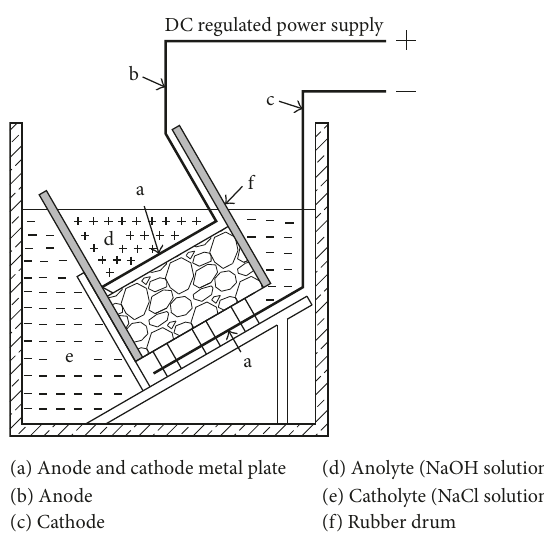
Figure 2: Experimental setup for the NSSCM